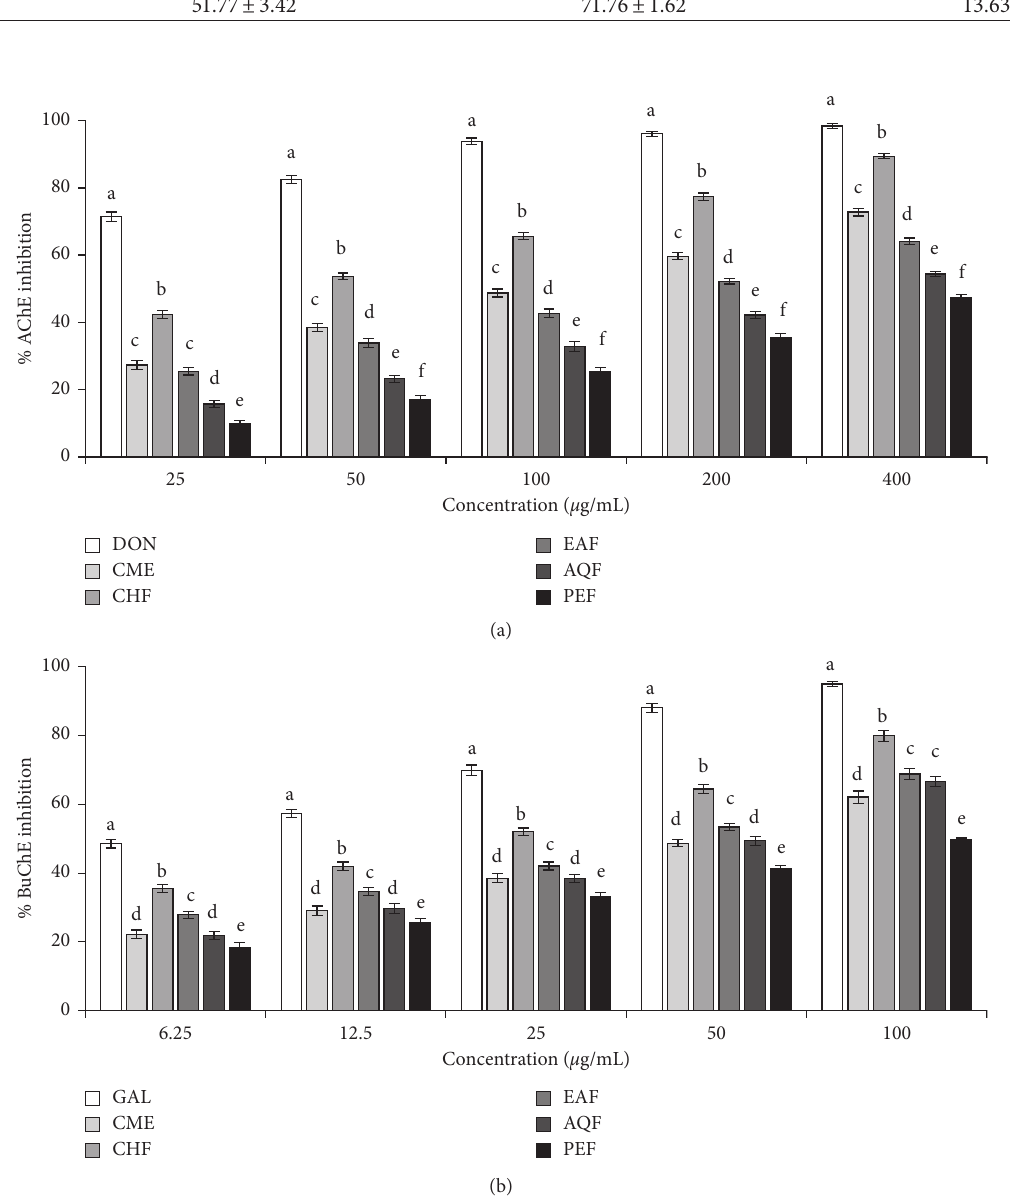
Figure 2: Anticholinesterase activity of the crude methanol extract of Sjaponica and its fractions . (a) AChE inhibitory activity. IC DON, 5.21 ± 0.18; CME, 104.13 ± 1.86; CHF, 40.06 ± 0.79; EAF, 159.57 ± 2.57; AQF, 308.57 ± 2.27; PEF, 453.17 ± 4.28. (b) BuChE inhibitory activity. IC 50 ( µ g/mL): GAL, 7.91 ± 0.35; CME, 50.44 ± 1.10; CHF, 18.78 ± 0.69; EAF, 35.30 ± 0.92; AQF, 44.73 ± 1.40; PEF, 100.08 ± 2.12. Results are expressed as mean ± SD ( n � 3). Means with different letters (a–f) differ significantly ( P < 0 . 05). CME, crude methanolic extract; CHF, chloroform fraction; EAF, ethyl acetate fraction; AQF, aqueous fraction; PEF, petroleum ether fraction; AChE, acetylcholinesterase; BuChE, butyrylcholinesterase; DON, donepezil; GAL, galantamine.